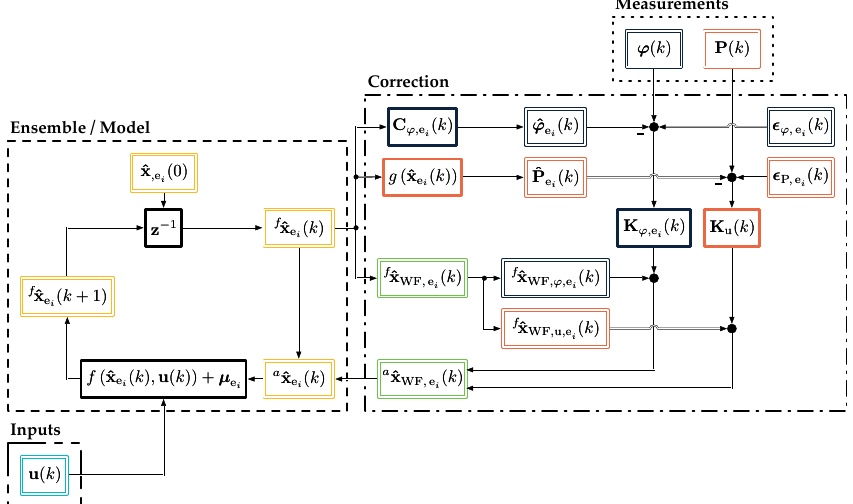
Figure 2. Block diagram of an ensemble with correction. The left box ( −− ) describes the state propagation within the ensemble. If no measurements are available, the system keeps progressing the state, and all ensembles diverge due to the influence of noise. The right box ( −· ) describes the comparison of the measurements with the estimates and the resulting correction. Elements connected to the wind direction are colored in dark blue, while elements related to the wind speed are colored in orange. Products and functions have a one-line frame; values have a double line